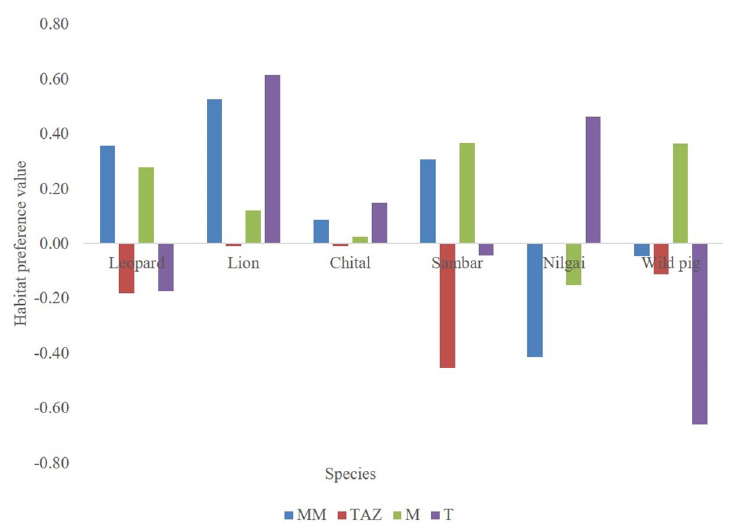
Fig 11. Habitat preference of leopard, lion and their